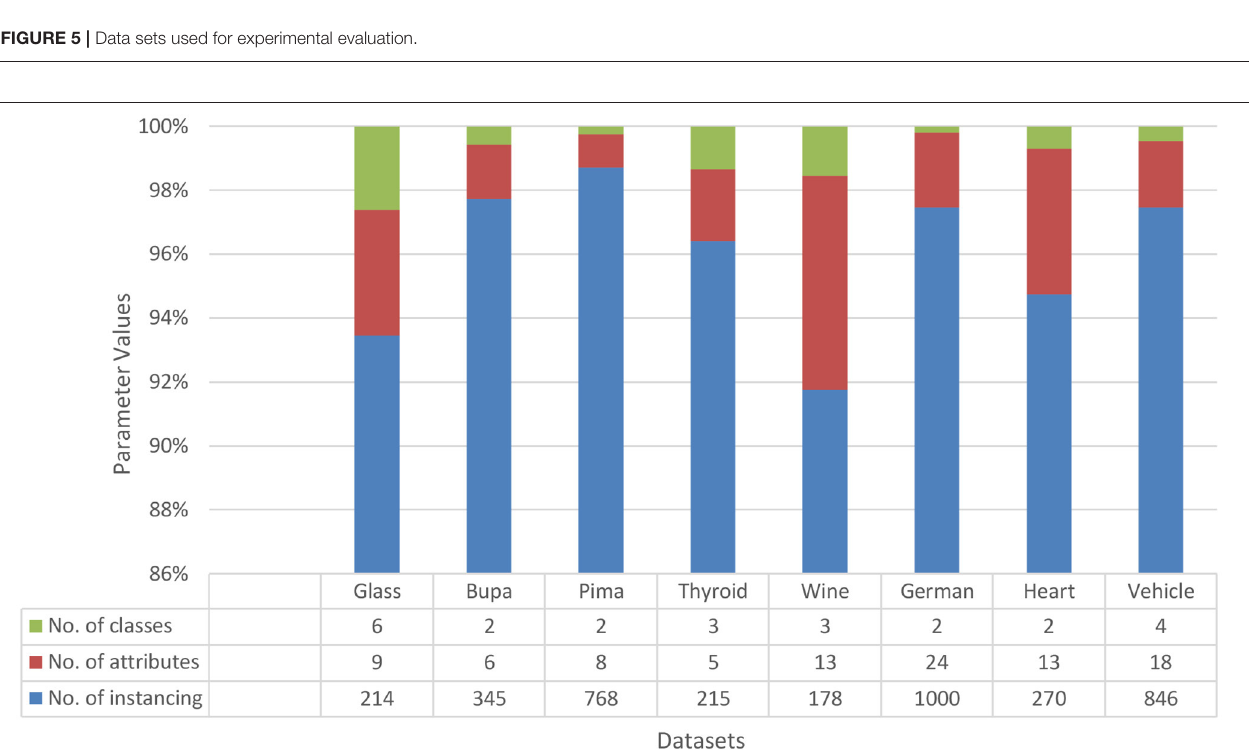
value between [ − 0.5, 0.5] is selected to tune the Weight wt. Dimension of wt is set to | ω | × l , where l denotes the number of classifiers. Each row in wt ij is tuned for ξ gc . Initially, the dot